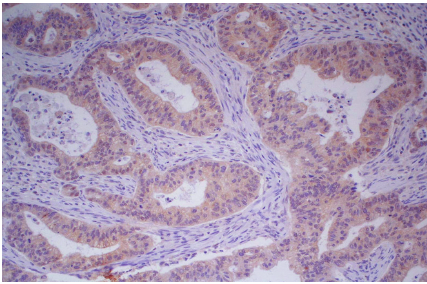
Figure 1: Poorly differentiated ethmoidal intestinal-type adenocar- cinoma (G3) showing high percentage of TRAIL expressing cells (magnification 20x).